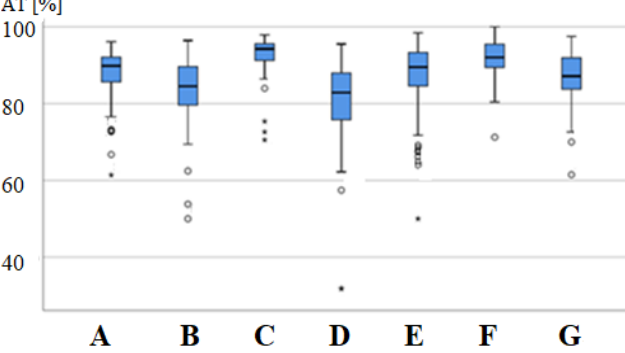
Figure 1. Frame chart of the buses ’ AT availability indicators. Table 2. Descriptive statistics for the buses ’ AT availability indicators.